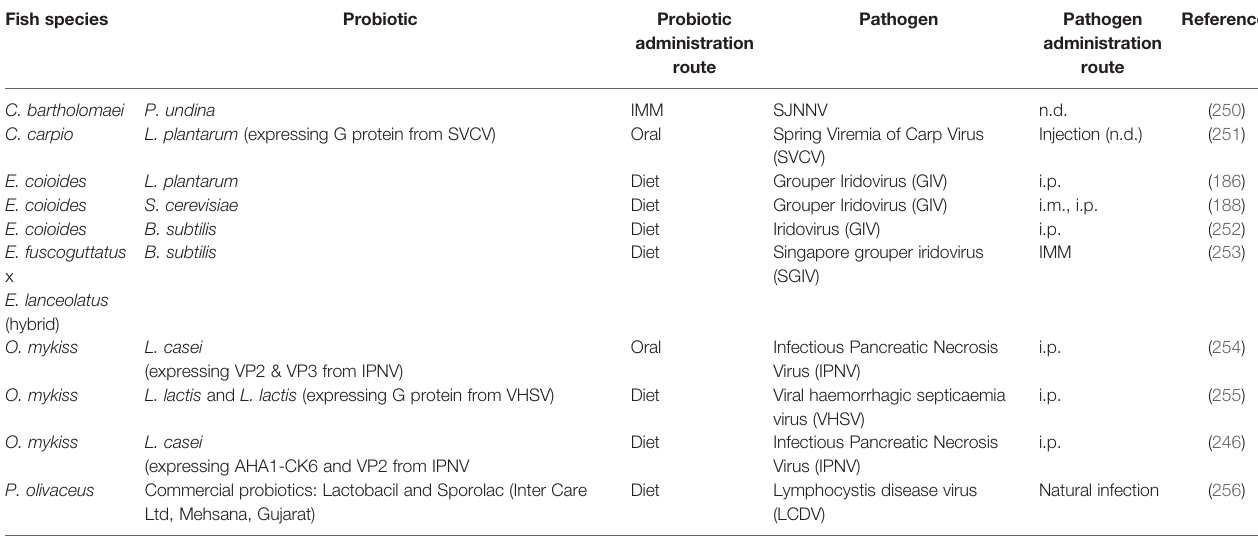
TABLE 2 | Probiotics assayed in vivo in aquacultured species which have shown to confer signi fi cant resistance against viral pathogens. Fish